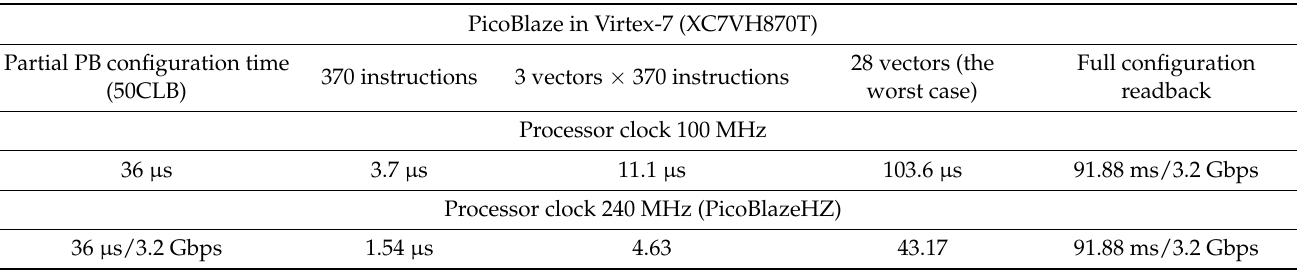
Table 6. Testing time vs. reconfiguration